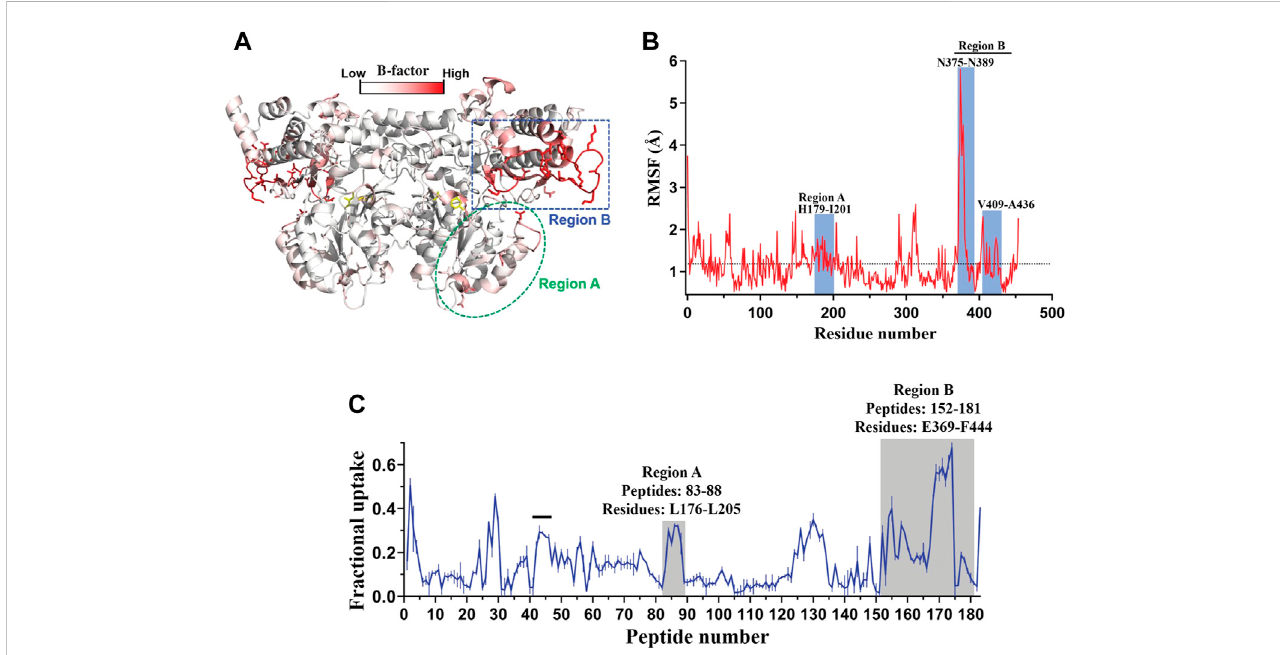
FIGURE 5 Flexibility analysis of HsKYNase based on B-factor, MD simulations and HDX-MS. (A) , The protein structure colored by B-factor values in HsKYNase. (B) , Calculated RMSFvaluesofHsKYNaseresiduesobtained andaveragedfromMDsimulations. (C) ,D 2 OuptakeofHsKYNaseafter 1 minexposure intheabsence of ligand. Reprinted with permission from (Karamitros et al., 2022). Copyright 2022 National Academy of